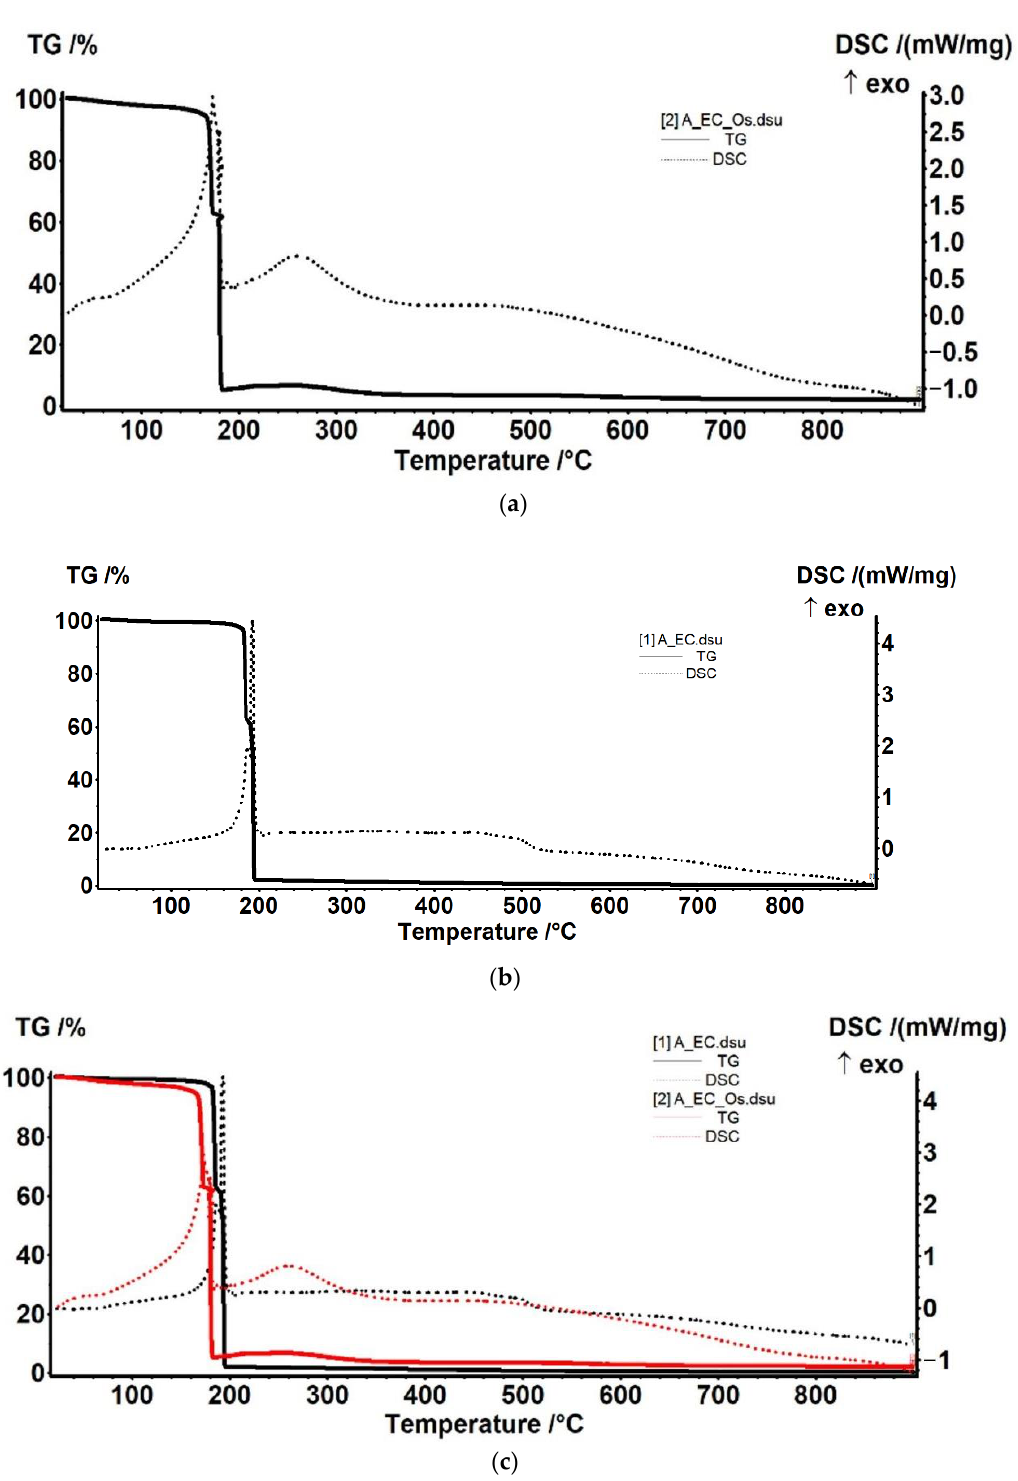
Figure 11. The thermal diagrams for: osmium – cellulose acetate membrane (Os – CA) ( a ); cellulose acetate (CA) ( b ); and their overlap ( c ).